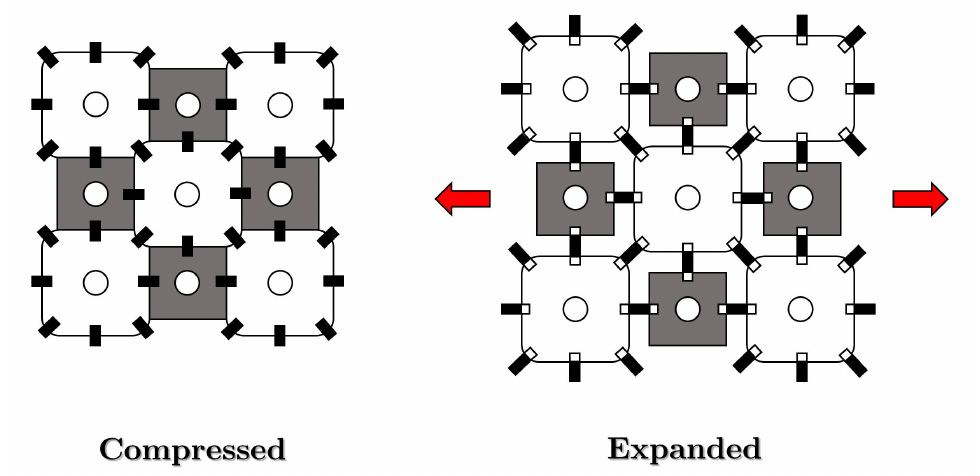
Figure 18. Schematic of a keyed brick structure.